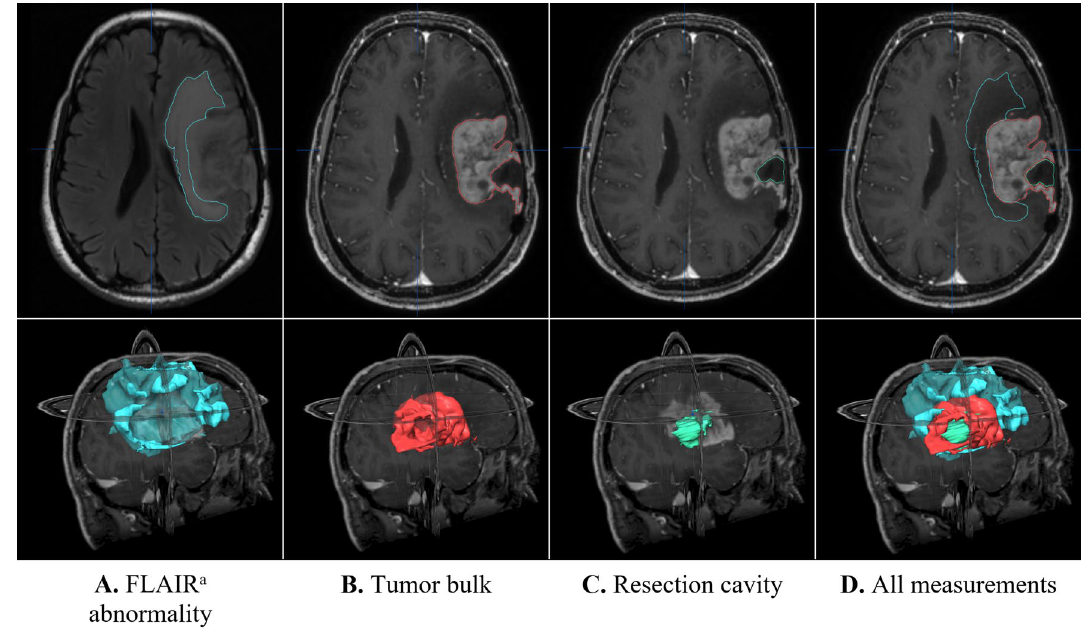
Figure 1. Volumetric measurements of postoperative MRI imaging. All volumetric measurements were done by using BrainLab IPlannet 3.0 software (Brainlab AG, Munich, Germany). Pre-operative measurements of FLAIR a T2-weighted (FLAIR a abnormality) and contrast-enhanced T1-weighted magnetic resonance imaging (tumor bulk and resection cavity) in a patient with recurrent HGG with prior tumor resection who underwent a repeat resection with Gliadel wafers. a T2-Weighted fluid-attenuated inversion